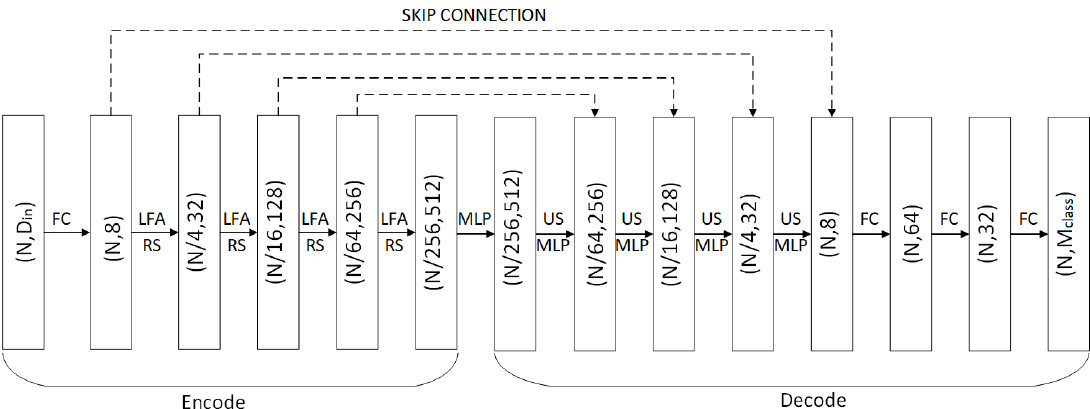
Figure 2. The structure of RandLA-Net.